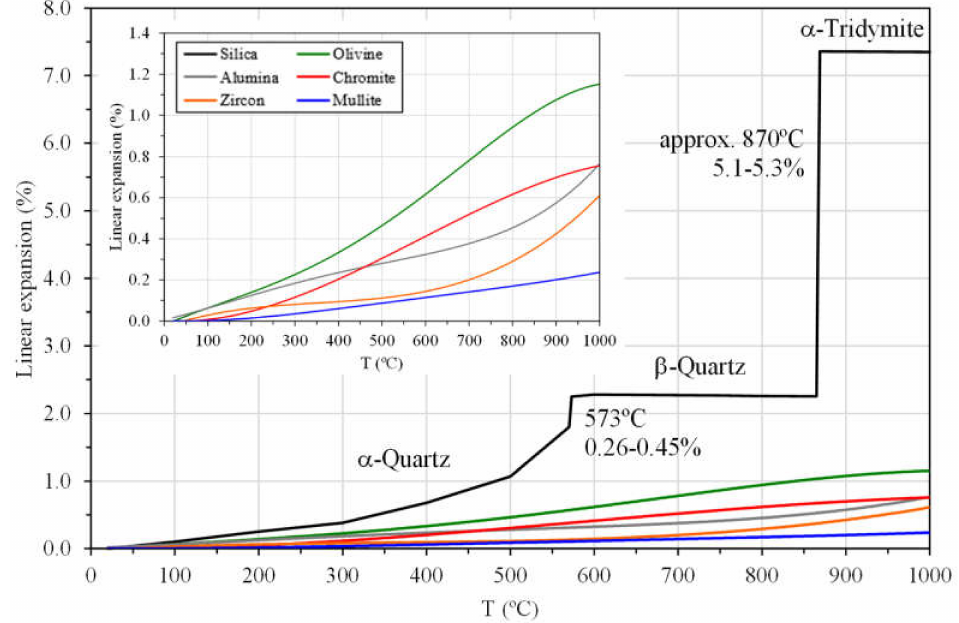
Figure 21. Schematic comparing the thermal expansion of different phases constitutive of molding sands